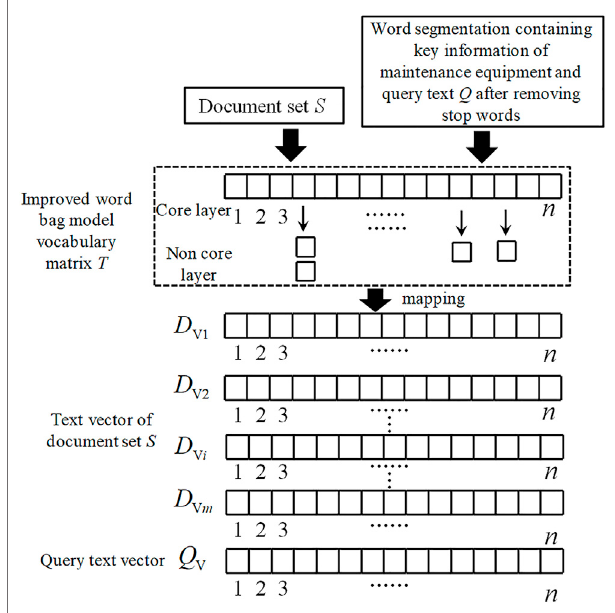
FIGURE 4 | Schematic diagram of improved word bag